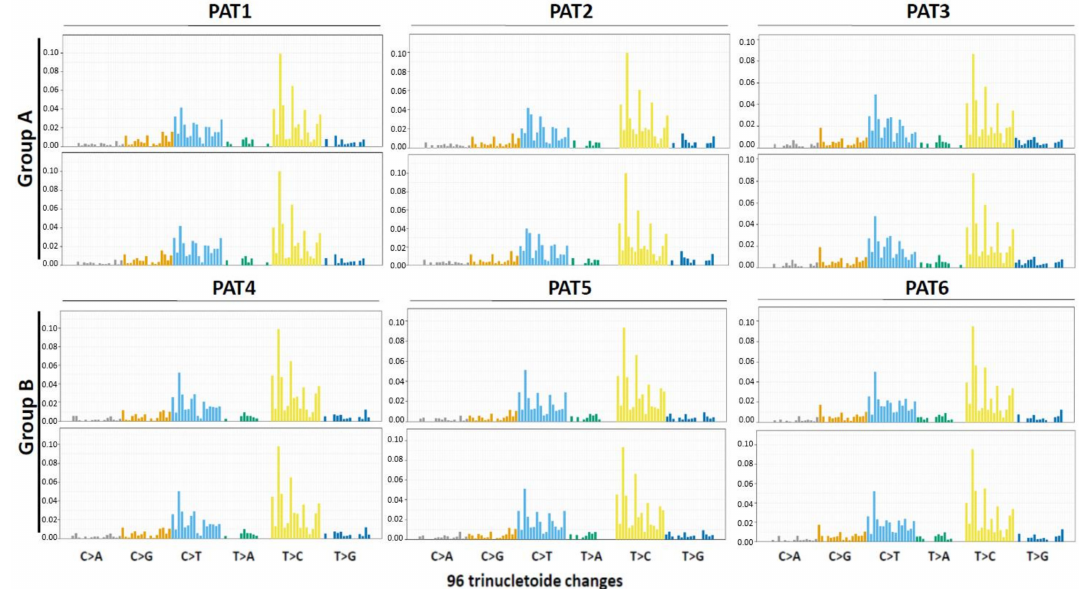
Figure 2. Mutational signatures (see Methods) in group A (PAT1, 2 and 3) and group B (PAT4, 5 and 6) patients. PAT: Patient. The upper panels refer to the primary tumors, the lower panels to the matched metastatic